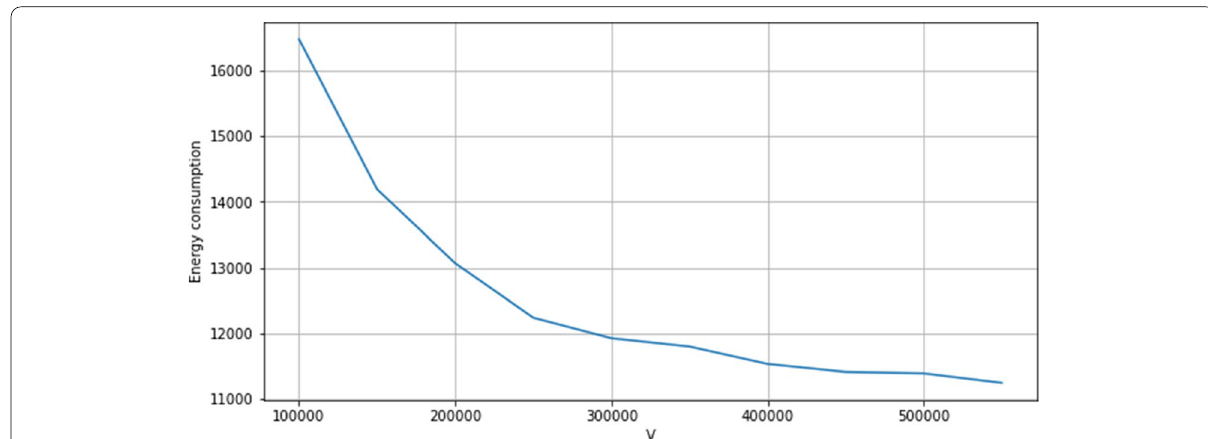
Fig. 2 Time-average energy consumption with different V